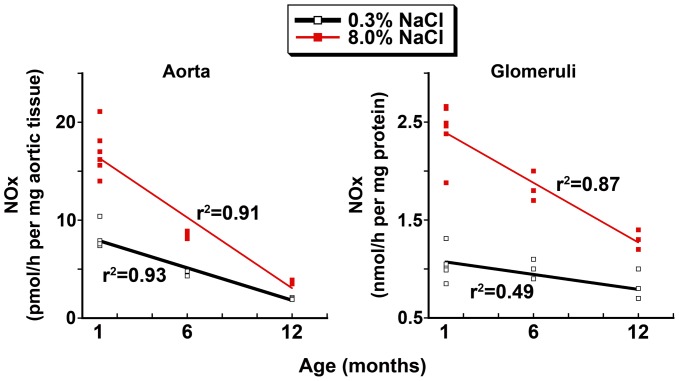
NOx production rates by vascular tissues (aorta on left and isolated glomeruli on right) obtained from rats 1, 6 and 12 months of age.Findings from animals on 8.0% and 0.3% NaCl diets were analyzed separately. For aortic rings and isolated glomeruli from rats on both diets, a statistically significant inverse linear correlation was observed (p-values<0.05), indicating a steady decline in bioavailable NO in these tissue with age. Each square in the graphs represents data from a single rat.